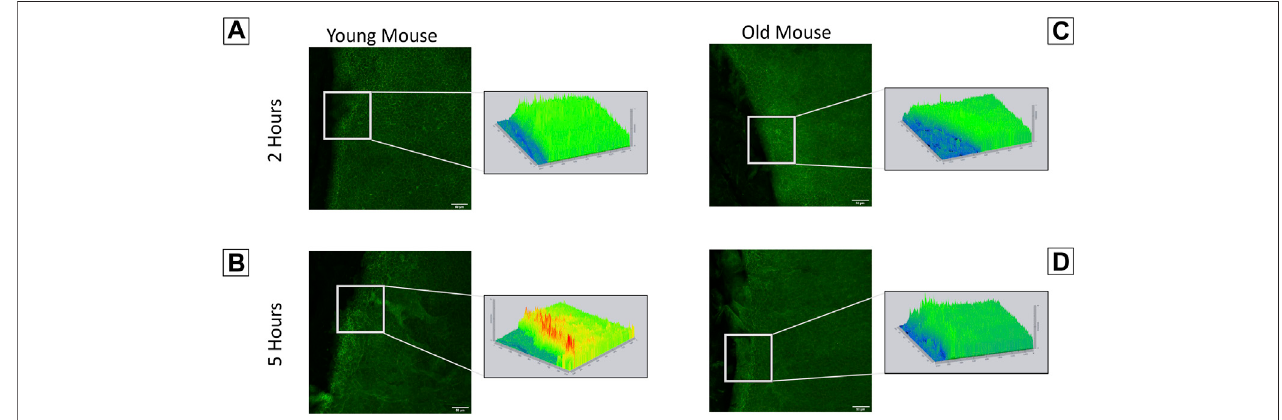
FIGURE7| Localizationofpannexin-1iselevatedincorneasfromyoungermiceatthewoundedge.Enucleatedglobeswerescratchwoundedandallowedtoheal for two or 5 h. Globes were fi xed in 4% paraformaldehyde, corneas were dissected, and immunohistochemistry was performed to visualize localization of pannexin-1 near thewound edge (green). Imagingwas performed using the ZeissLSM 880confocal microscope. Topographical maps denoting the intensity ofstainingthroughout the regionwere generated fromtheimagingdata. (A) In younger mice,pannexin-1 localizationisdiffuseat 2 h, withsimilar expression adjacenttoand further away from the wound. This is seen in the topographical map as a relatively fl at, green diagram. (B) In younger mice at 5 h, the increase in pannexin-1 near the wound edge is detected as red peaks in the topographical map. (C,D) Older mice have a similar localization of pannexin-1 throughout the epithelium at both two and 5 h. The data represent three eyes per condition, with each eye from one mouse. Scale bar is 50